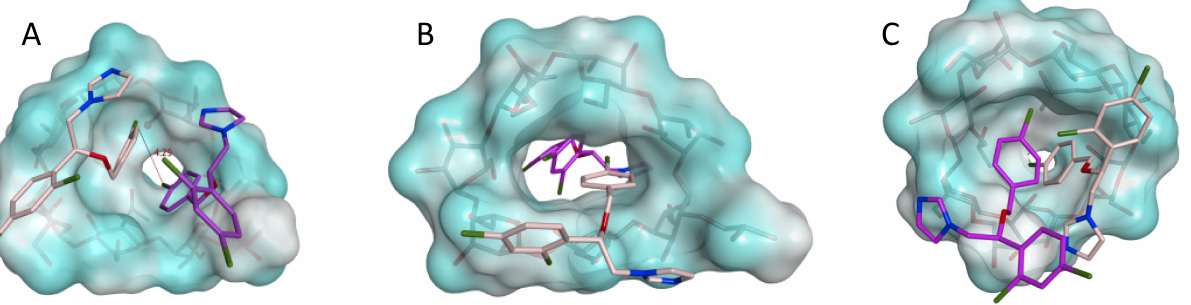
Figure 4. Two proposed inclusion complex models: econazole–HP- β -CD complex in a 2:1 ratio with the two drugs entering the same side of the cyclodextrin ( A ), and econazole–HP- β -CD complex in a 2:1 ratio with the two drugs on the opposite side of the cyclodextrin ( B ). Econazole carbon atoms are in pink (Eco-1) and purple (Eco-2). HP- β -CD is represented as a molecular surface. ( C ) is the final complex model for complex 4B. Eco-1 (pink) remained inside the cyclodextrin while Eco-2 (purple) approached the complex from the same side. Water molecules from the simulation environments have been removed for the clarity of the image.